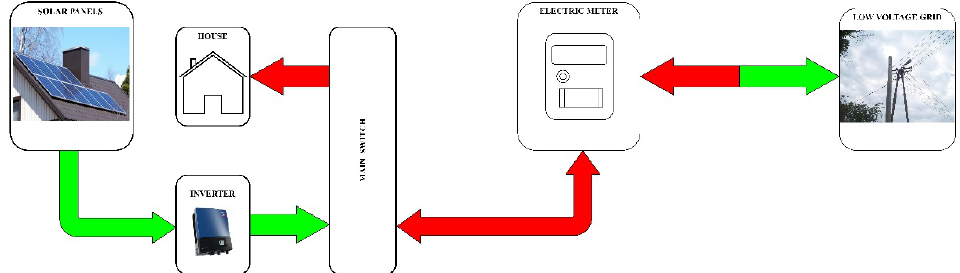
Figure 1. Typical photovoltaic micro-installation without energy storage.